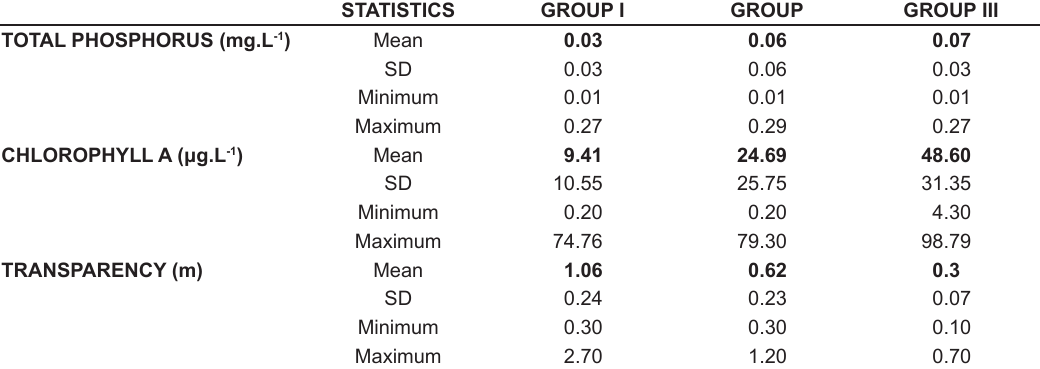
Table 4. Mean values of the variables studied for the water eutrophication groups of the reservoirs in the Banabuiú